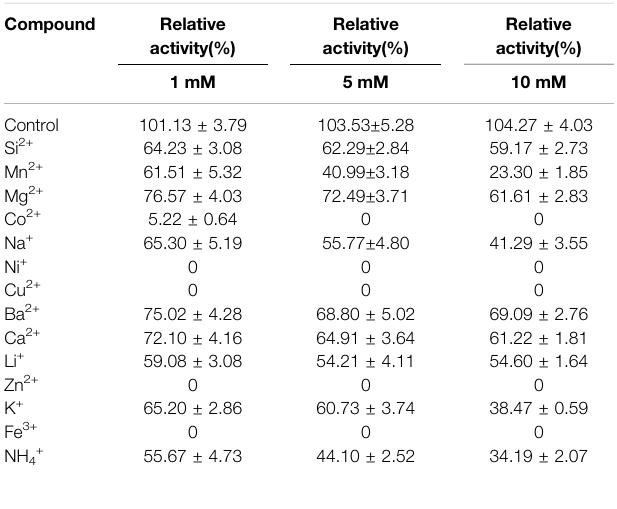
TABLE 2 | Inhibition of metal ions to dextranase Compound Relative Relative activity(%)